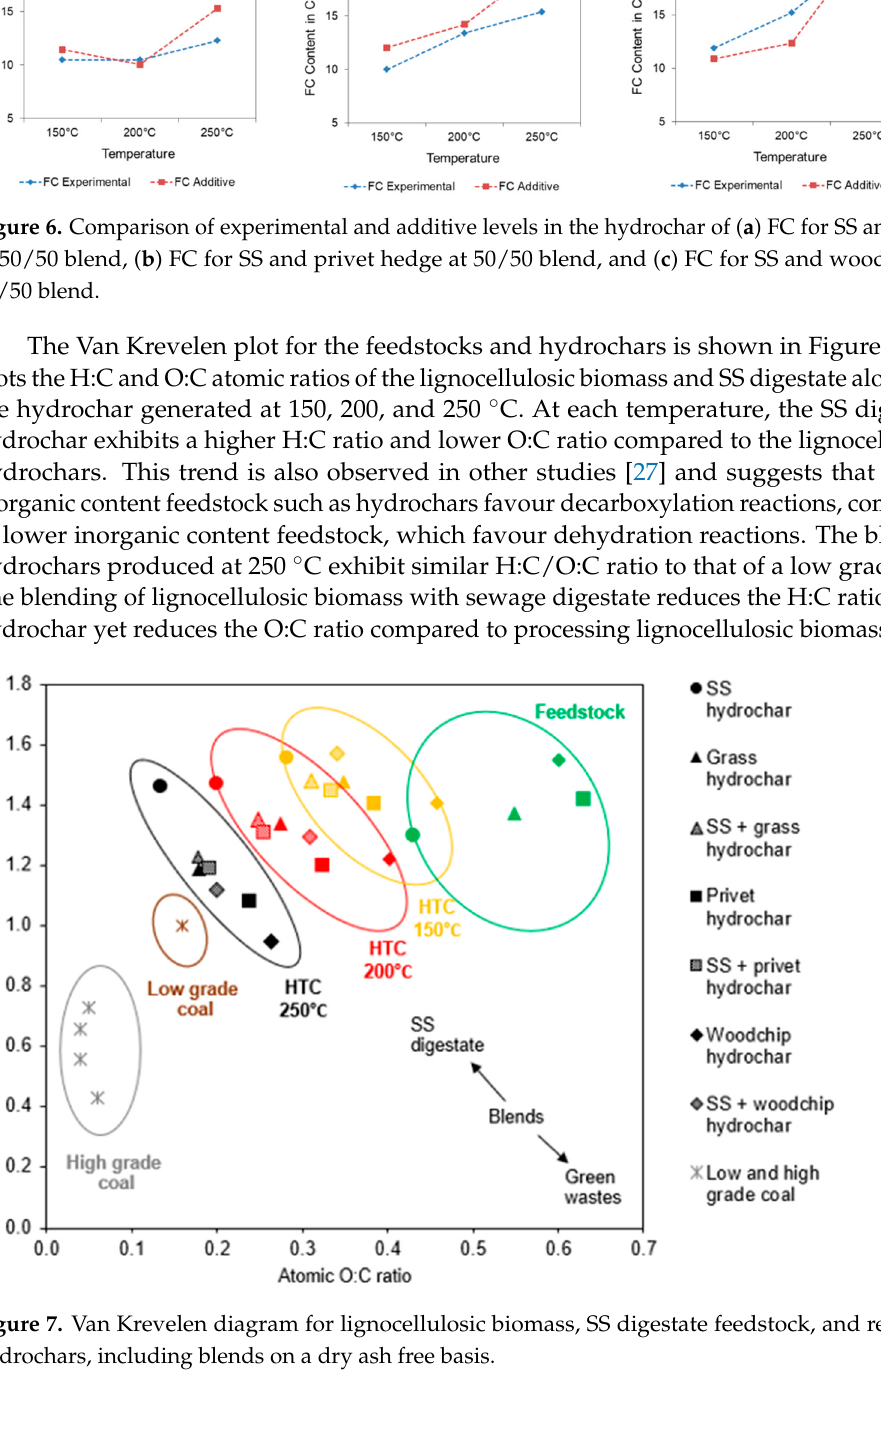
Figure 7. Van Krevelen diagram for lignocellulosic biomass, SS digestate feedstock, and resultant hydrochars, including blends on a dry ash free basis.